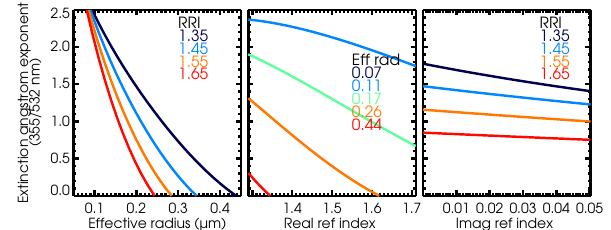
Figure 1. The sensitivity of the extinction Ångström exponent to the effective radius and complex refractive index is shown. The left panel shows the dependence of extinction Ångström exponent ( y axis) on effective radius ( x axis) for four values of the real re- fractive index (colors); the imaginary refractive index is held fixed at 0.003 and the geometric standard deviation is held fixed at 1.48 (values from Case 1 in Table 1). The middle panel shows the de- pendence on real refractive index along the x axis, parameterized by effective radius. The right panel shows the dependence on the imaginary refractive index ( x axis) for four values of the real re- fractive index; in this case, median radius is held fixed at 0.12µm and geometric standard deviation is held fixed at 1.48 (values also from Case 1 in Table 1).